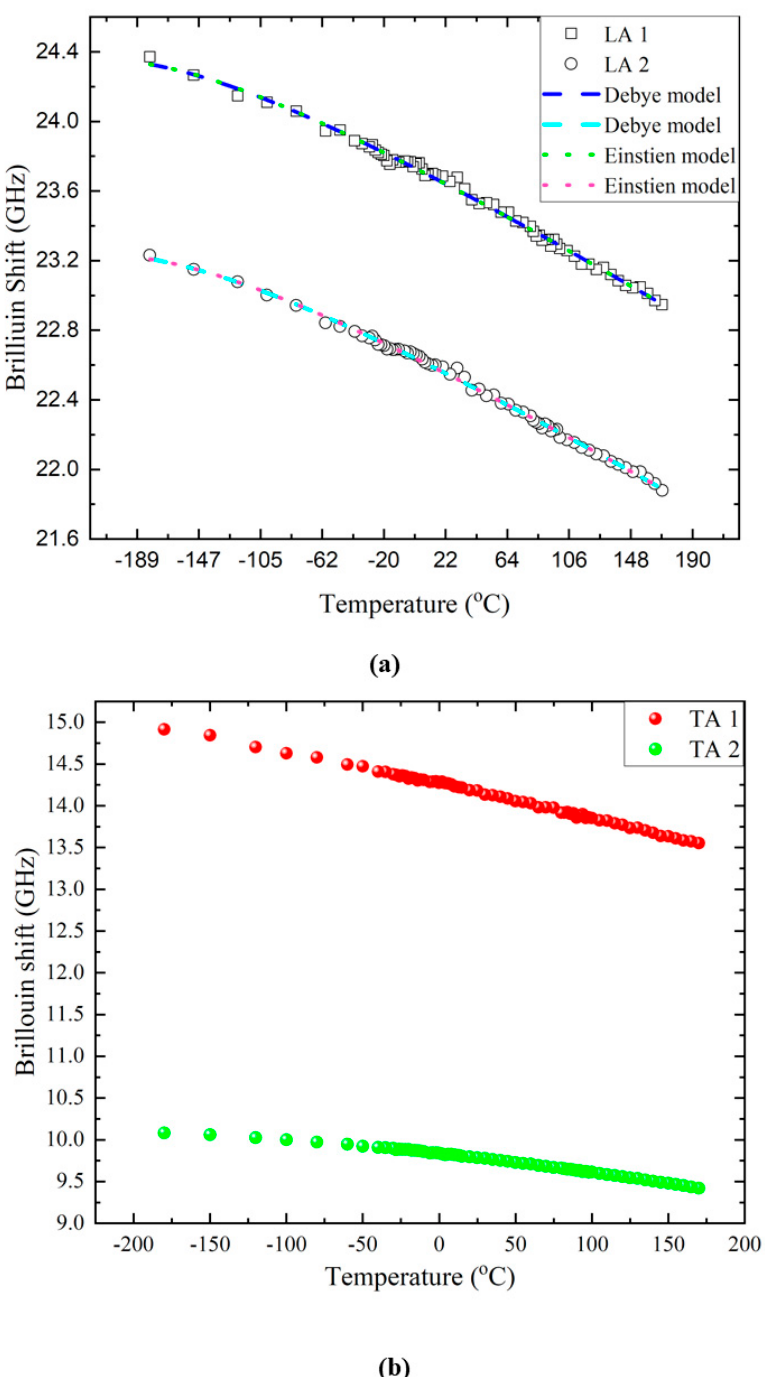
Figure 4. Temperature dependences of the Brillouin frequency shift of ( a ) the LA modes and ( b ) the TA modes. The dotted and dashed lines in ( a ) denote the best-fitted results by the Debye and the Einstein models. See the text for details. Table 1. The best-fitted results for the LA modes by using two models as described in the text.